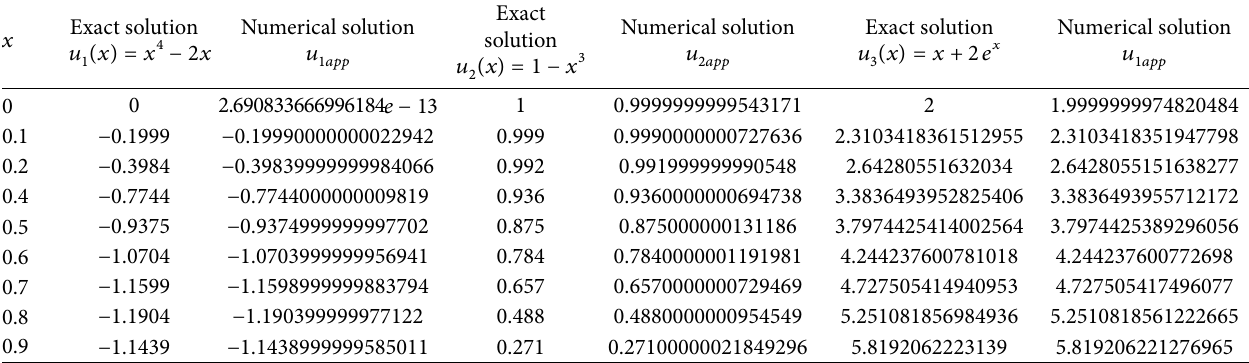
Table 3: The exact and numerical solutions of applying Algorithm 2 for system (66).